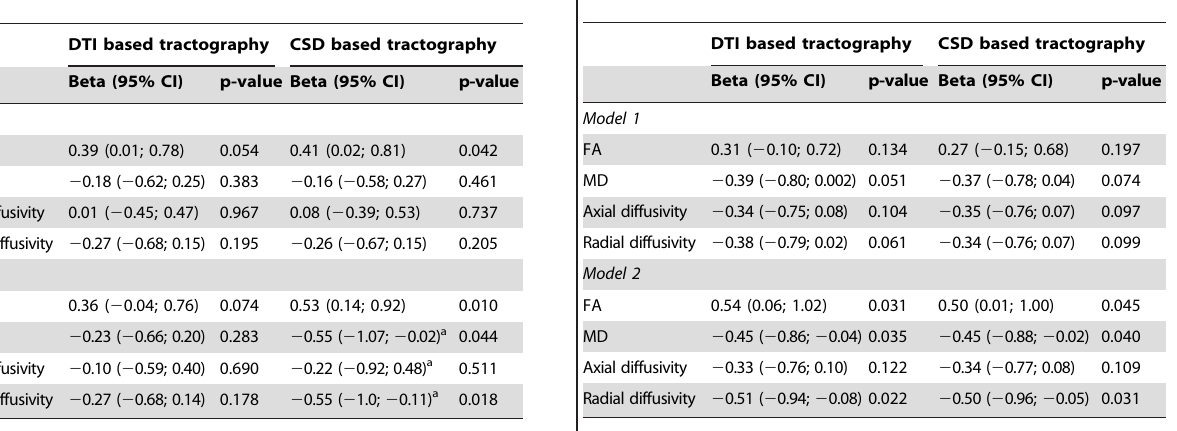
Table 1. Association diffusion parameters of the SLF and memory performance.